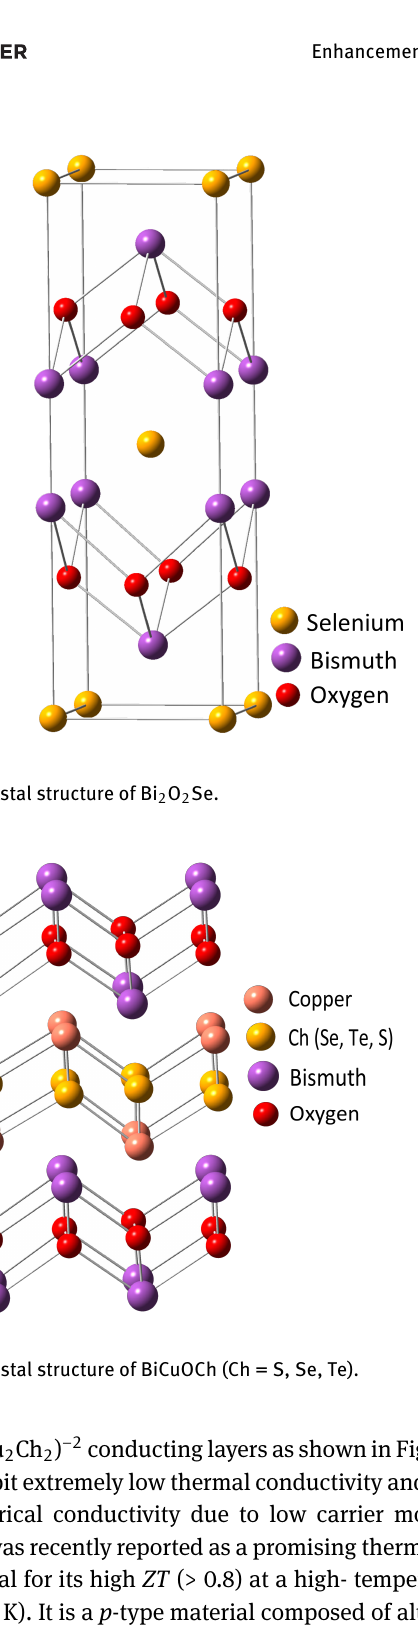
ers and (Cu 2 Ch 2 ) −2 conducting layers as shown in Figure